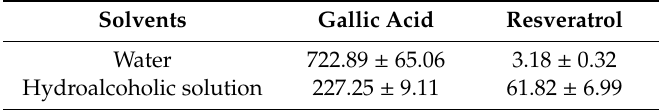
Table 3. Phenolic compound levels (mg / g extract) in water and hydroalcoholic extracts from C. minima .